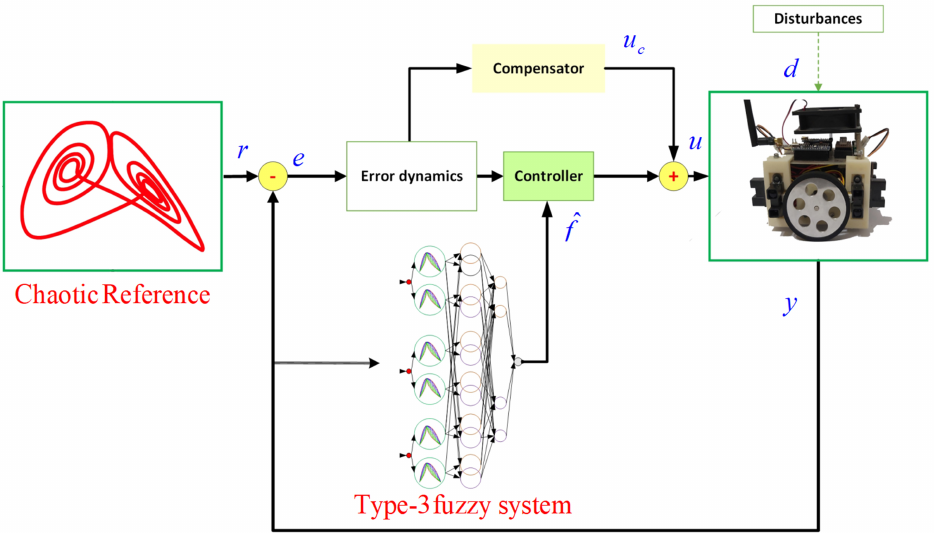
Figure 1. Control structure.